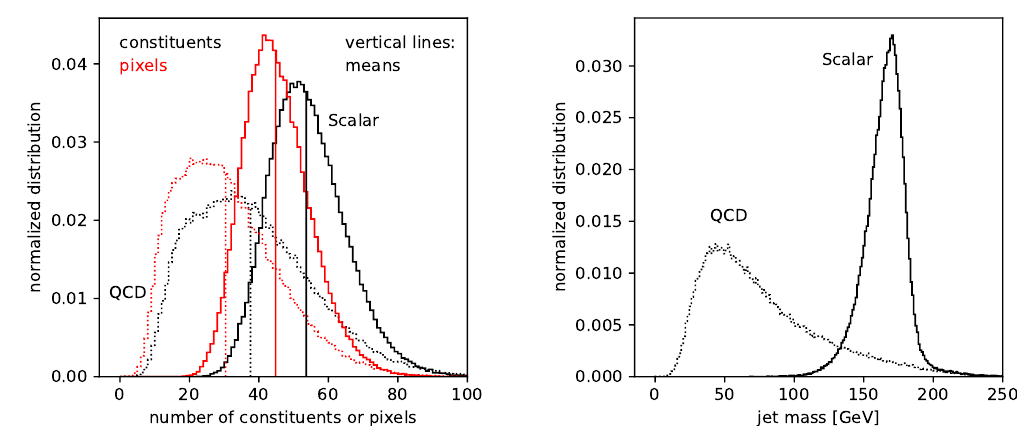
Figure 8: Left: numbers of constituents and of non-zero pixels for scalar decay jets and QCD. Right: truth-level jet mass distributions for the signal and the QCD back-